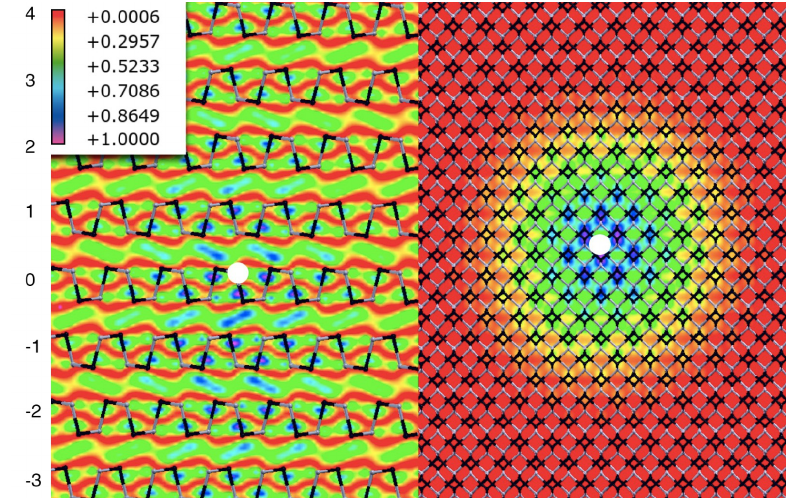
Figure 5. Plot of the square modulus of the first bright excitonic wavefuction, fixing the hole position near an S atom, represented by the white dot at the center. Side view on the left, top view on the right. Numbers indicates the layers with respect to the one with the